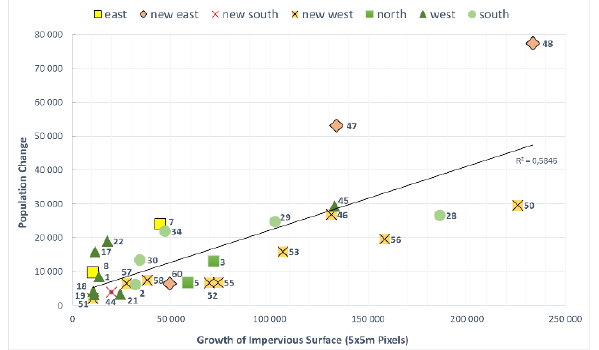
Figure 6: Investigated area of Ward 34 “Danilimda”